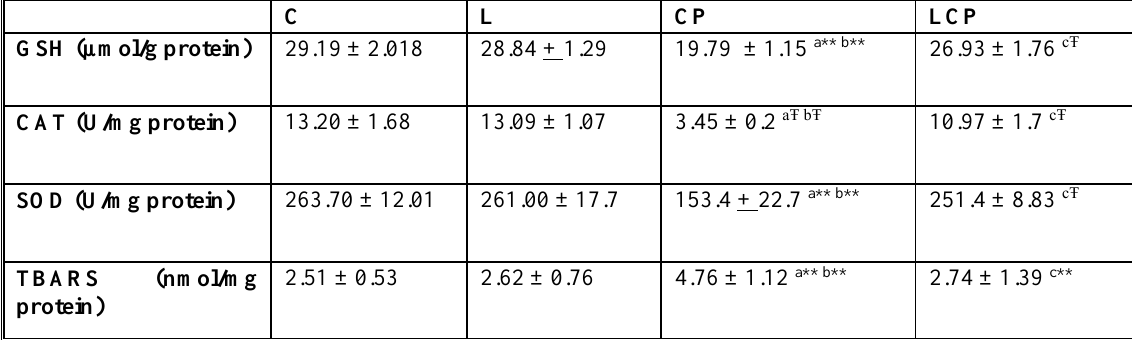
Table 2. The cortical GSH, CAT and SOD enzyme activities and TBARS in different groups of